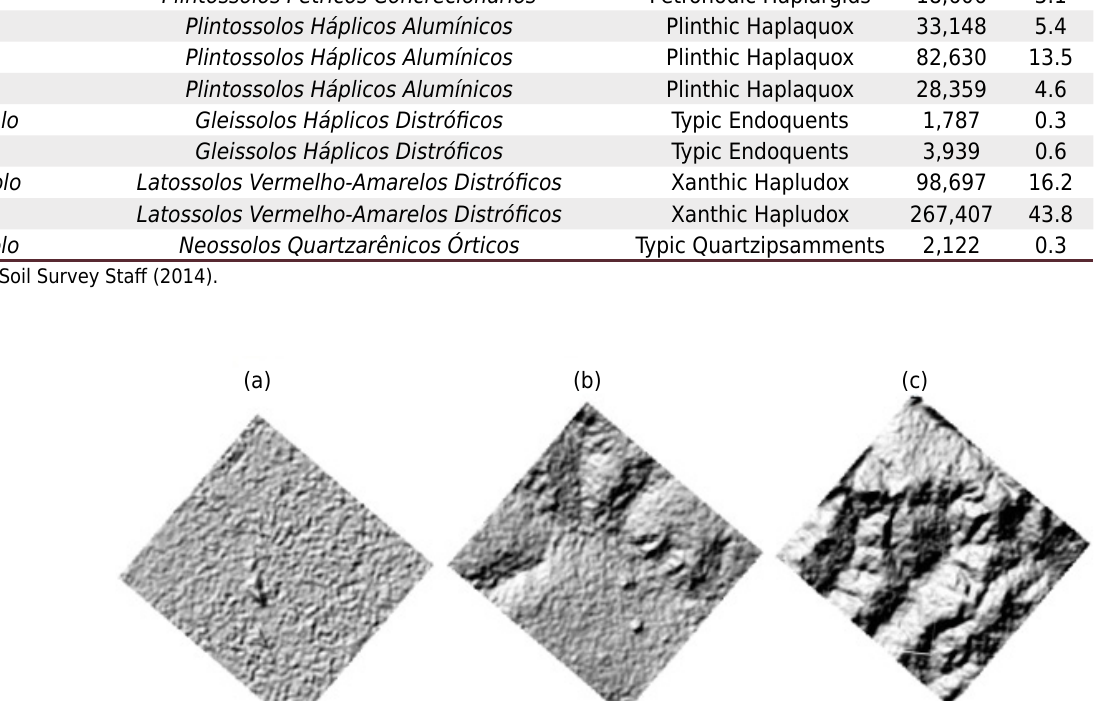
Soil class Brazilian system of soil classification (1)